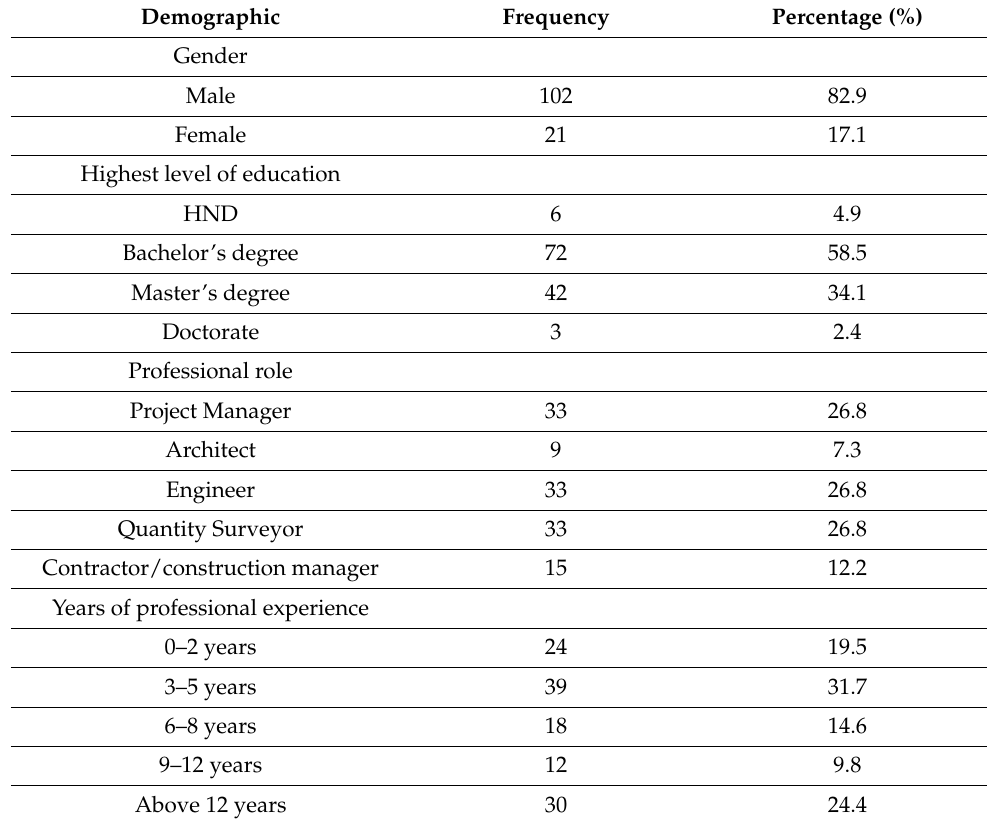
Table 1. Demographic